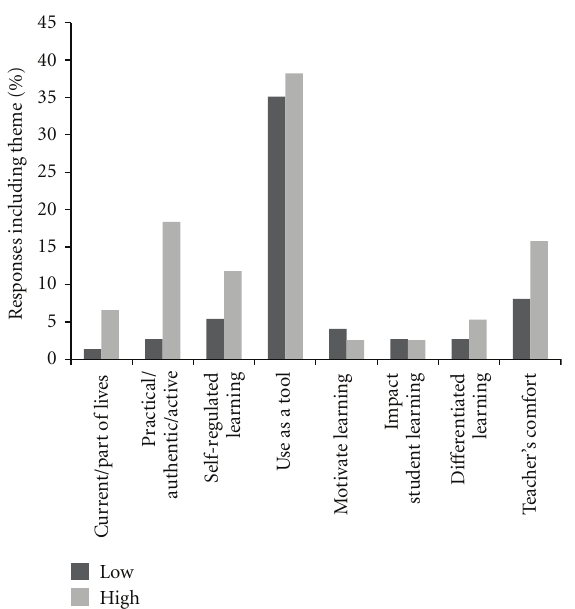
Figure 3: Patterns of themes by integration level to fit with instructional style.